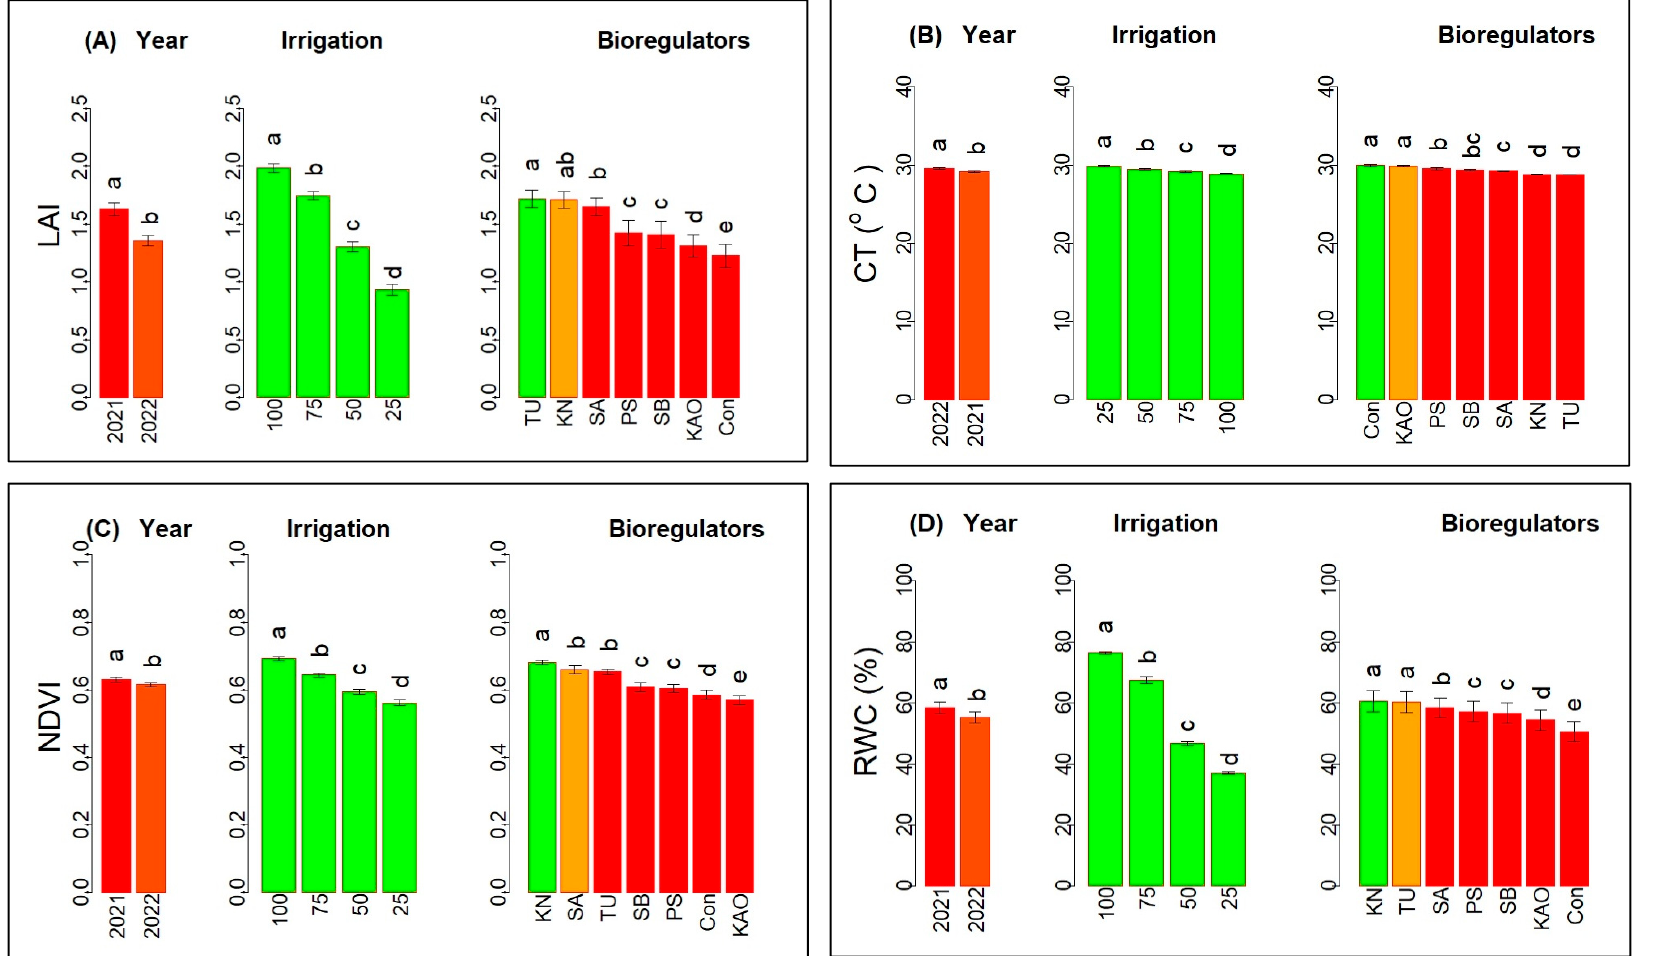
Figure 4. Effect of irrigation and bioregulators on growth and physiology of chia: ( A ) leaf area index (LAI), ( B ) canopy temperature (CT), ( C ) normalized difference vegetation index (NDVI), and ( D ) relative water content (RWC).